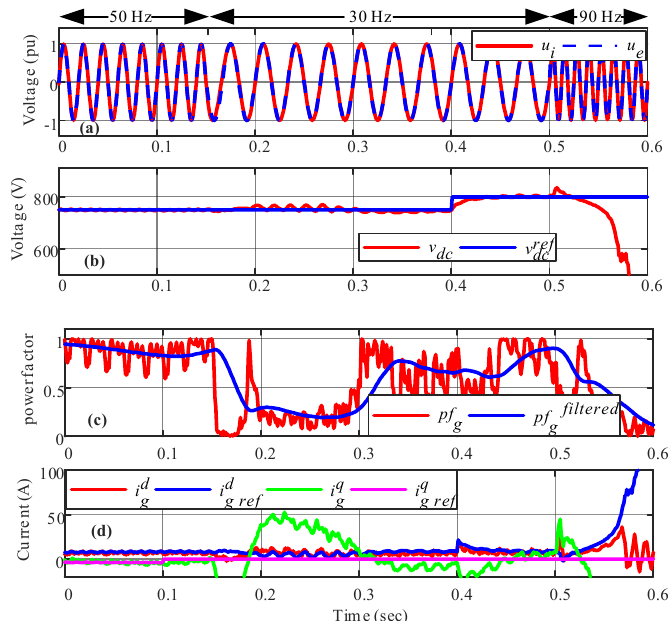
Figure 7. Linear control response; ( a ) synchronization; ( b ) dc voltage; ( c ) power factor; ( d ) input rectifier currents.